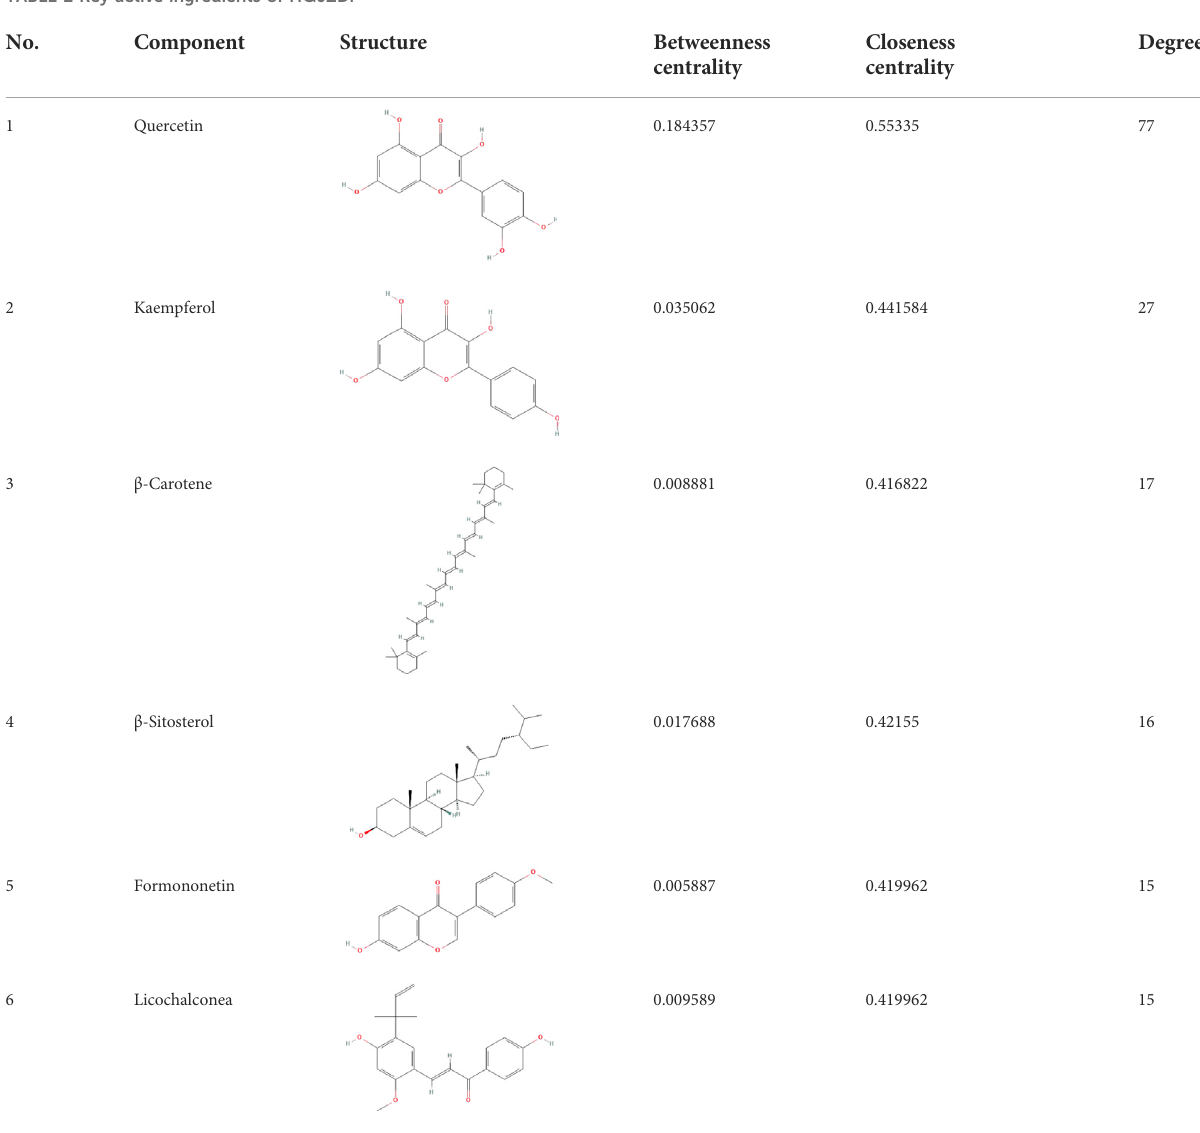
TABLE 2 Key active ingredients of HQJZD.